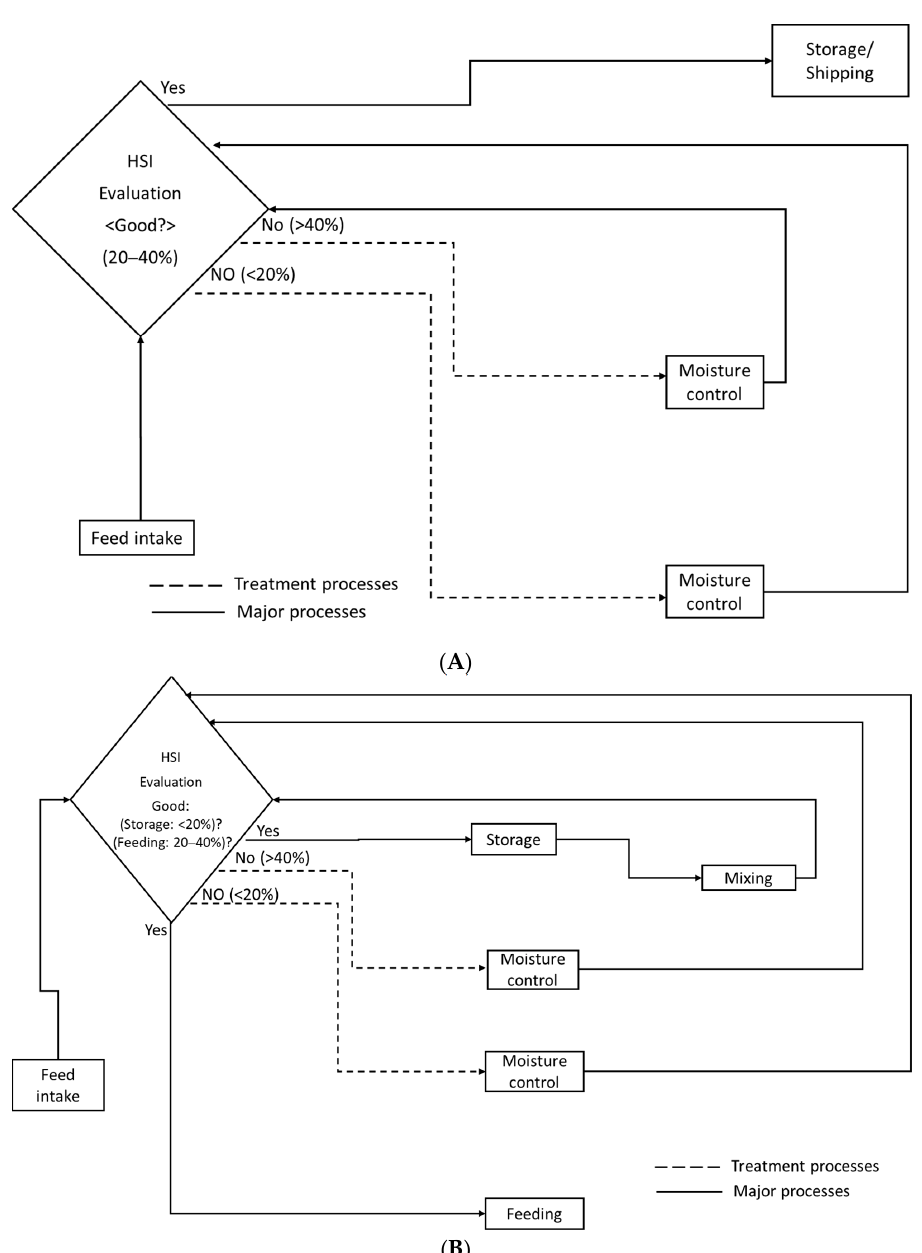
Figure 9. Model for production of TMR feed with precise moisture content and DMI in the factory ( A ); on the farm ( B ).